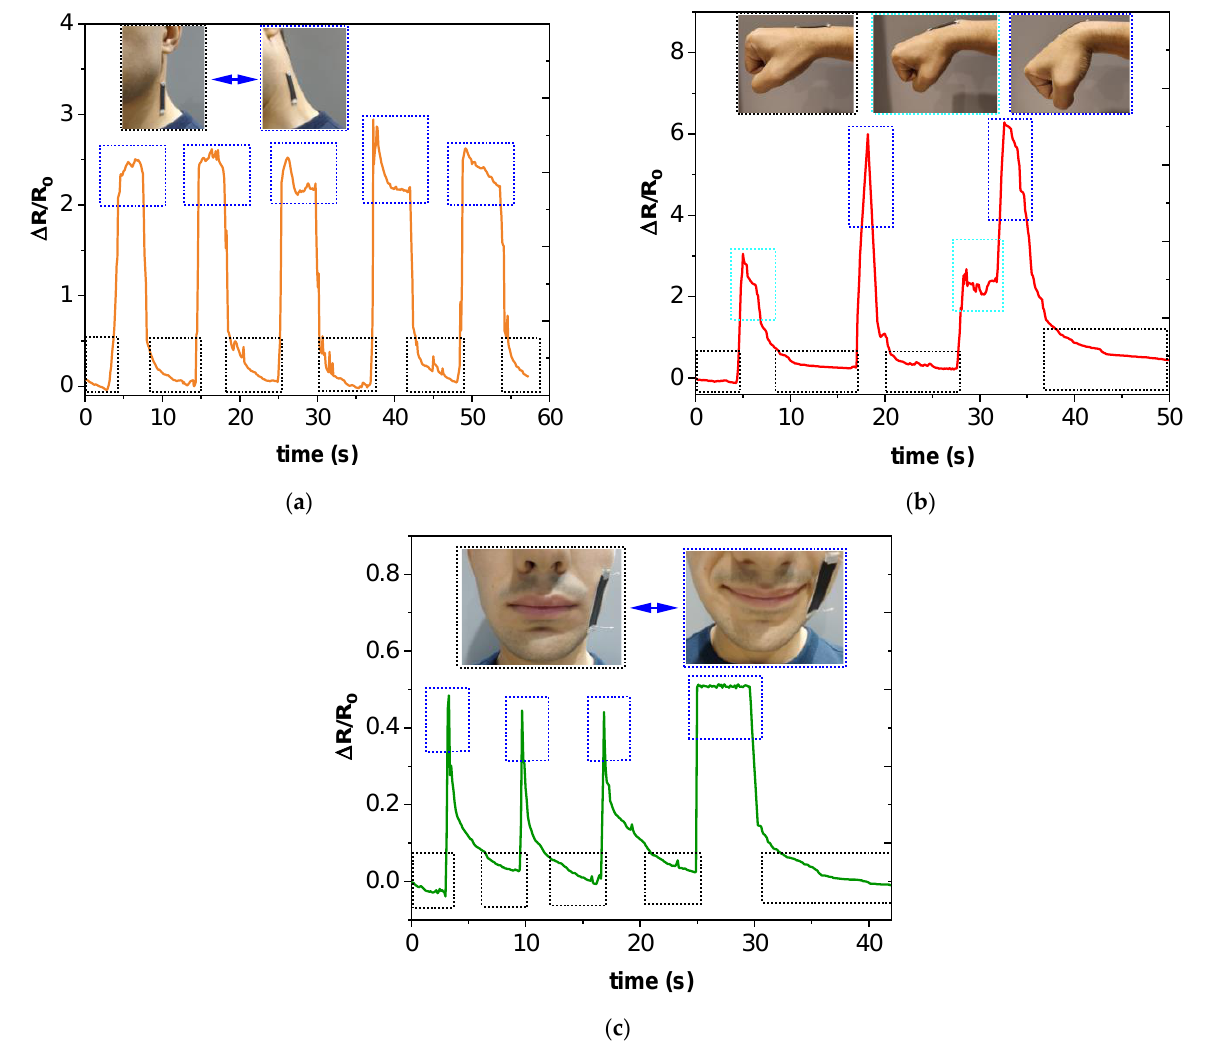
Figure 7. Proof-of-concept tests of ( a ) neck, ( b ) wrist and ( c ) facial movements monitoring.